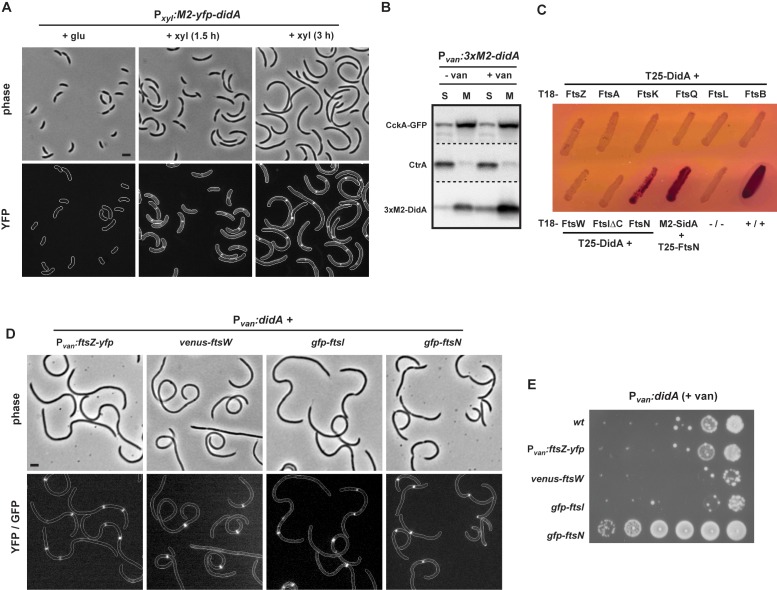
DidA is a small, inner membrane protein that interacts with FtsN.(A) The subcellular localization of DidA was examined in a strain expressing M2-yfp-didA from the xylose-inducible promoter Pxyl on a low-copy plasmid. Cells were grown to mid-exponential phase in rich media with glucose and then shifted to xylose. At the times indicated, cells were imaged by phase and epifluorescent microscopy. In the fluorescent micrographs, cell boundaries were added after imaging. (B) Subcellular fractionation of cells overexpressing 3×M2-didA from the Pvan promoter on a medium-copy plasmid for 1.5 hours and expressing the transmembrane protein cckA-gfp from PcckA on the chromosome. Samples were fractionated into soluble (S) and membrane (M) fractions and analyzed by Western blot. The membrane was cut into three pieces, indicated by dashed lines, and probed with antibodies specific for the GFP, CtrA, or M2 epitope. (C) Bacterial two-hybrid analysis of interactions between T25-DidA and cell division proteins fused to T18, as indicated. The FtsIΔC construct lacking the C-terminal catalytic domain previously showed interactions with FtsW and FtsN as expected, unlike the full-length version of FtsI [13]. The interacting pair T18-M2-SidA and T25-FtsN was included for comparison. E. coli strains harboring each pair of fusions were plated on LB, and colonies were restruck on MacConkey plates containing maltose. Red streaks indicate positive interactions. −/− indicates empty vectors negative control, +/+ indicates the zip/zip fusions used as a positive control. (D) Subcellular localization of FtsZ, FtsW, FtsI, and FtsN were examined in strains expressing ftsZ-yfp from the chromosomal Pvan promoter, or venus-ftsW, gfp-ftsI or gfp-ftsN from its native chromosomal locus. Each strain was transformed with a medium-copy plasmid expressing didA from the Pvan promoter. Strains were grown to mid-exponential phase and samples imaged by phase and epifluorescent microscopy after addition of vanillate for 4.5 hours. In the fluorescent images, cell outlines were drawn based on the phase micrographs. Bar, 2 µm. (E) Strains from (D) were grown to mid-exponential phase and 10-fold serial dilutions were plated on rich media supplemented with vanillate to induce didA expression.